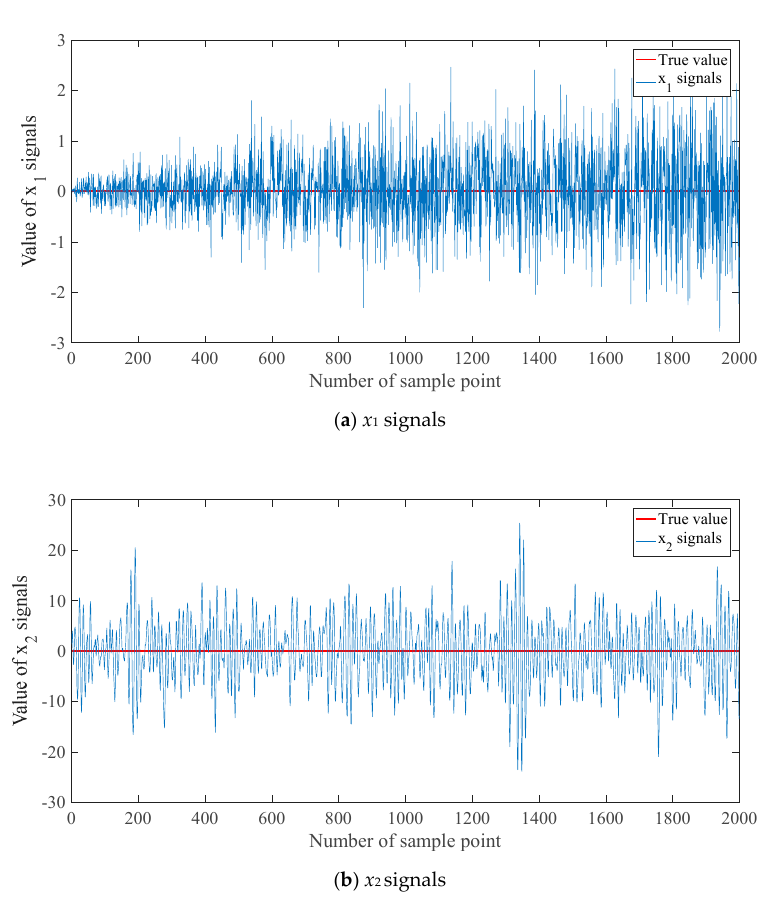
Figure 5. Simulation signals with different noises.